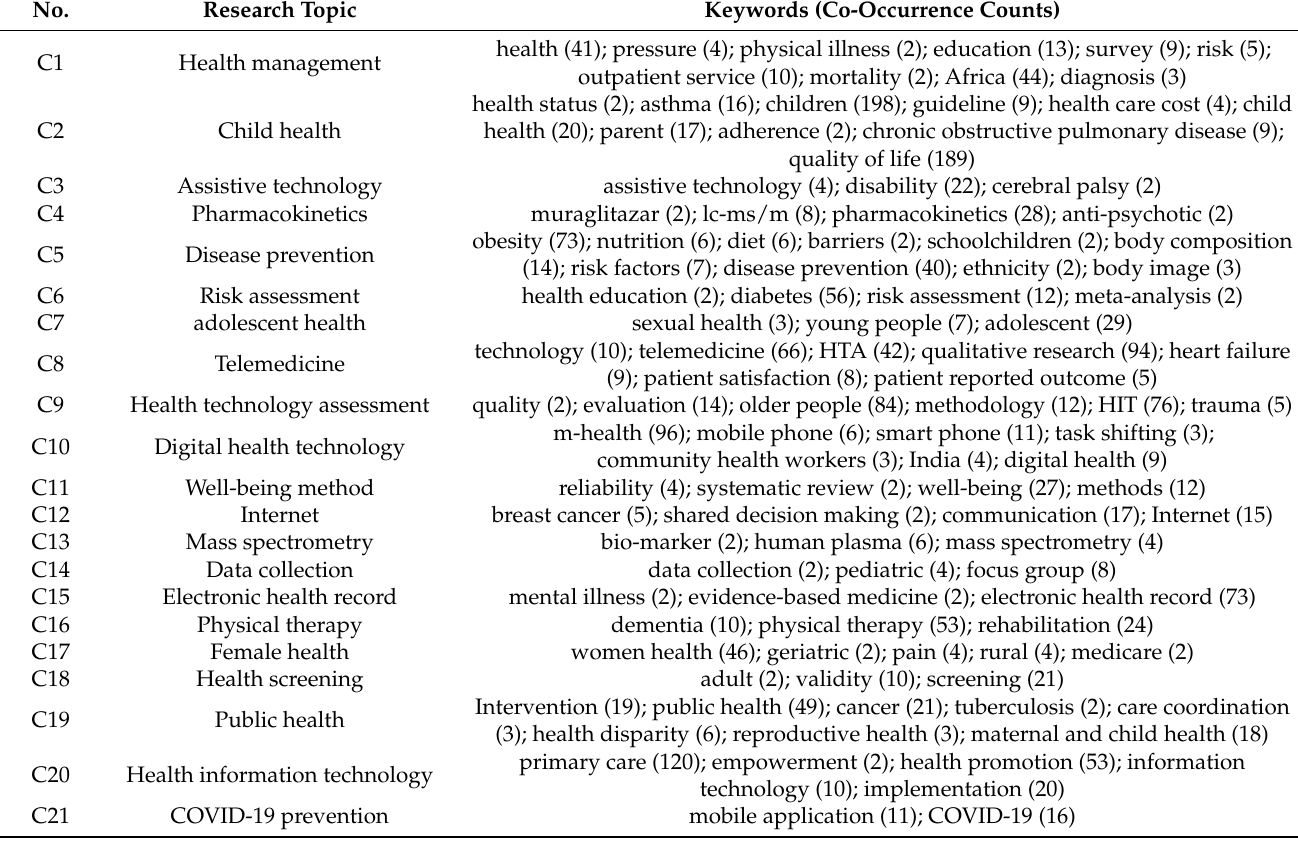
Table 5. Core research topics information